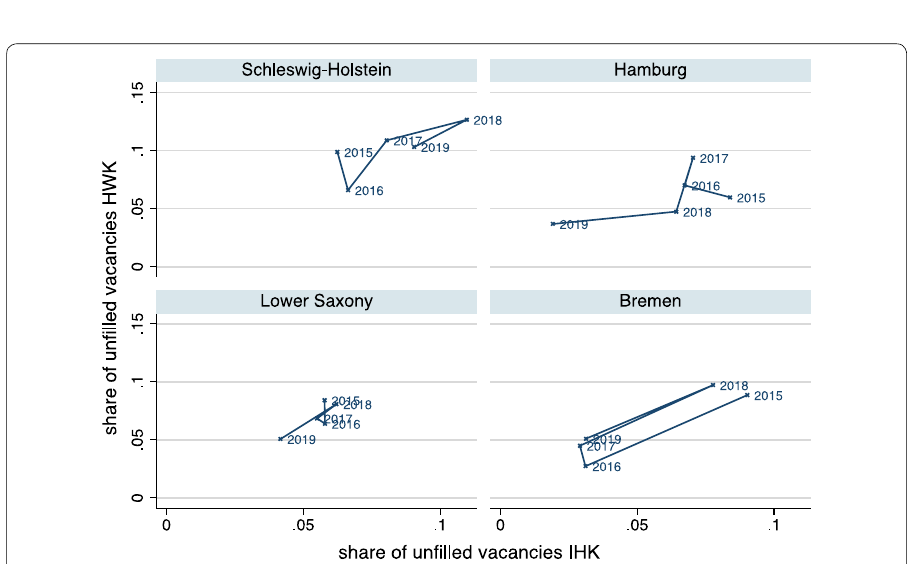
Fig. 14 Share of unfilled vacancies in craft (HWK) and industry and trade (IHK) for North-Western German states, 2015–2019. Data sources: Vocational training statistics of the statistical offices of the federal and state